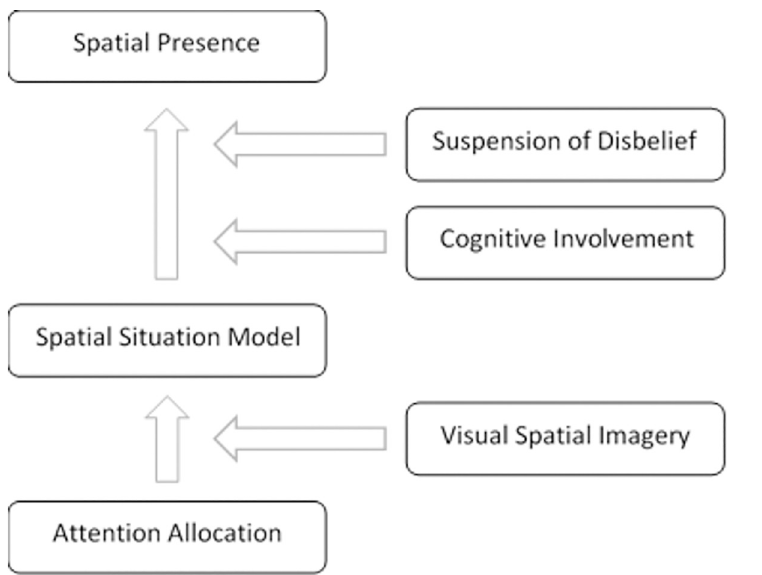
Fig 3. Our version of the MEC questionnaire adapted from Vorderer et al. [38].